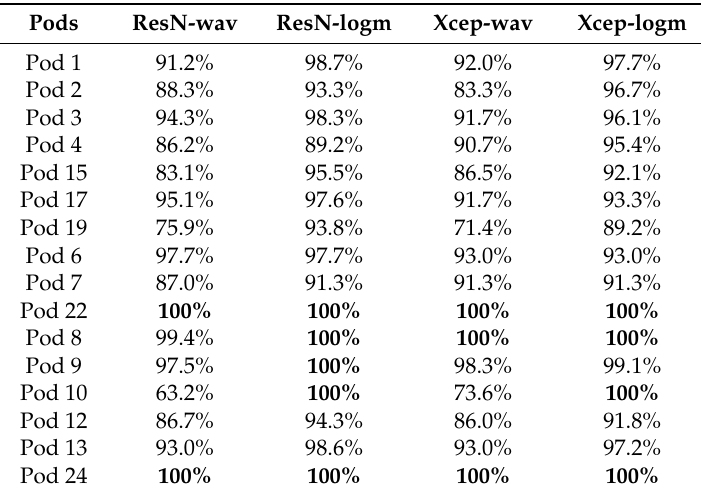
Table 3. Class-wise classification